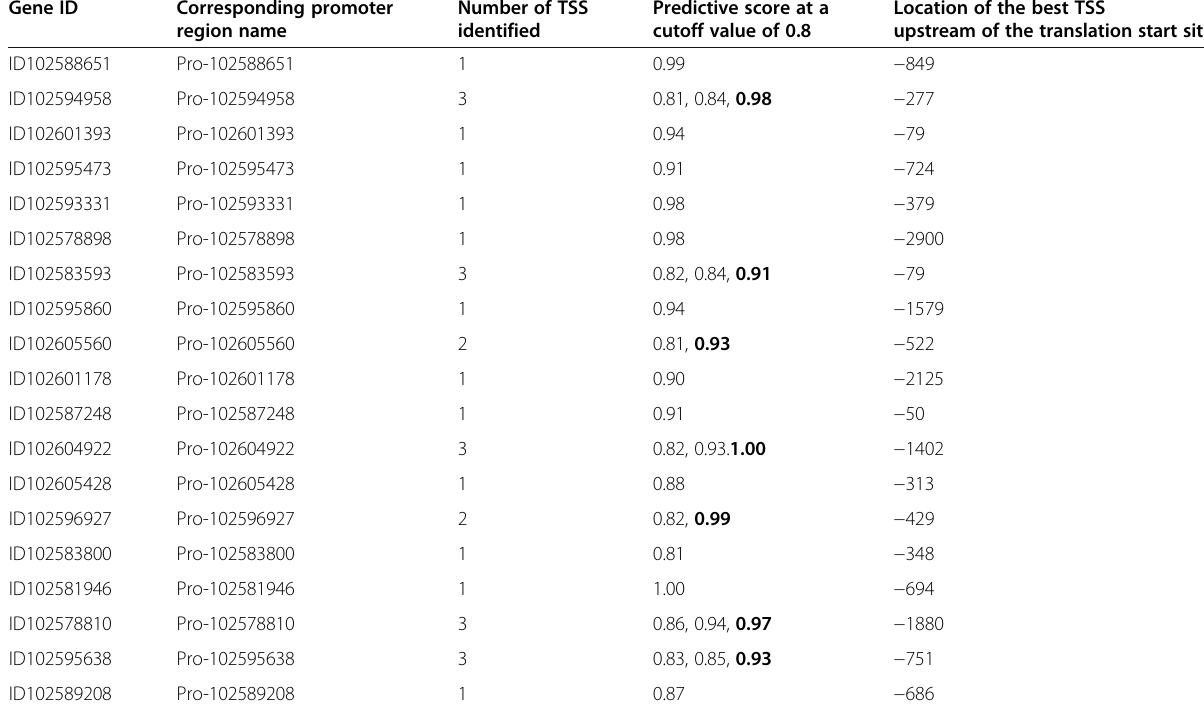
Table 2 Number and predictive score for glucan endo-1,3-beta-glucosidase genes of Solanum tuberosum cultivar DM 1-3 156 R44 TSSs Gene